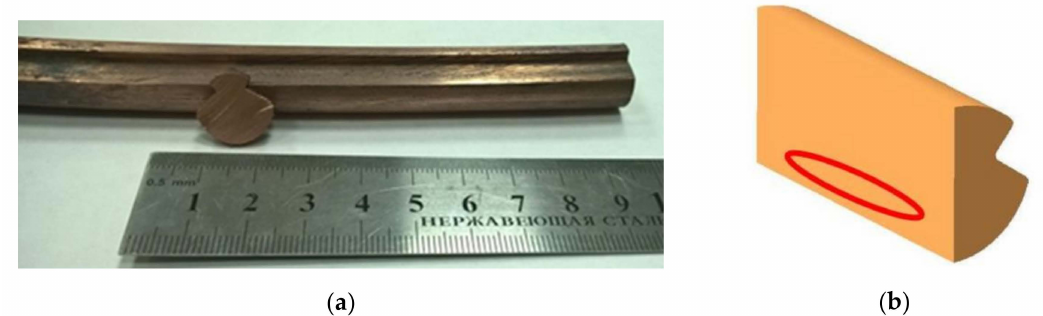
Figure 4. Laboratory samples after ECAP with wire forming ( a ) and area for microstructural analysis ( b ).